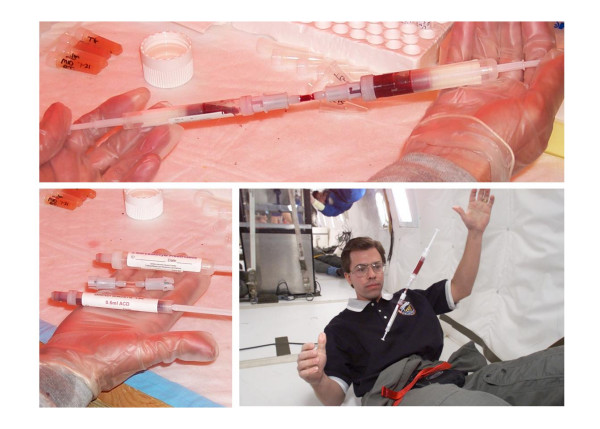
The Blood Collection/Preservation/Storage Apparatus (BCPSA) designed to safely preserve of whole blood samples during microgravity conditions. Whole blood is collected into a Monovette containing anticoagulant, and is transferred to a Monovette containing preservative via a novel interlink adaptor. Use of this device is highly advantageous during microgravity or field studies, as it greatly simplifies operations, reduces operator time and improves safety by nearly eliminating exposure to liquid blood samples. This device was validated during microgravity conditions onboard the NASA KC-135 parabolic flight aircraft in 2000, and utilized during the HMP 2002 immune study. Top and lower left: BCPSA in use at Devon Island; lower right: BCPSA evaluation during reduced gravity.